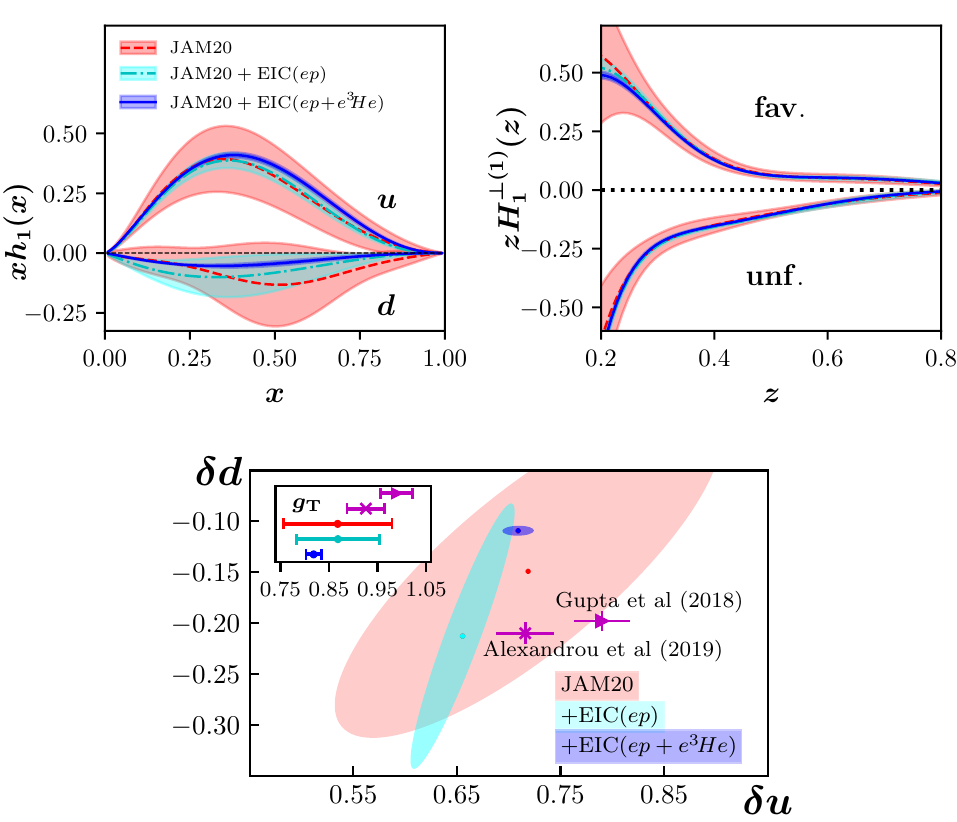
Figure 3: (Top) Plot of the transversity function for up and down quarks as well as the favored and unfavored Collins function first moment from the JAM20 global analysis (light red band with the dashed red line for the central value) as well as a re-fit that includes EIC Collins effect pion production pseudo-data for a proton beam only (cyan band with the dot-dashed cyan line for the central value) and for both proton and 3 He beams together (blue band with the solid blue line for the central value). (Bottom) Individual flavor tensor charges δ u , δ d as well as the isovector charge g for the same scenarios. Also shown are the results from two recent lattice T QCD calculations (purple) [ 23,25 ]